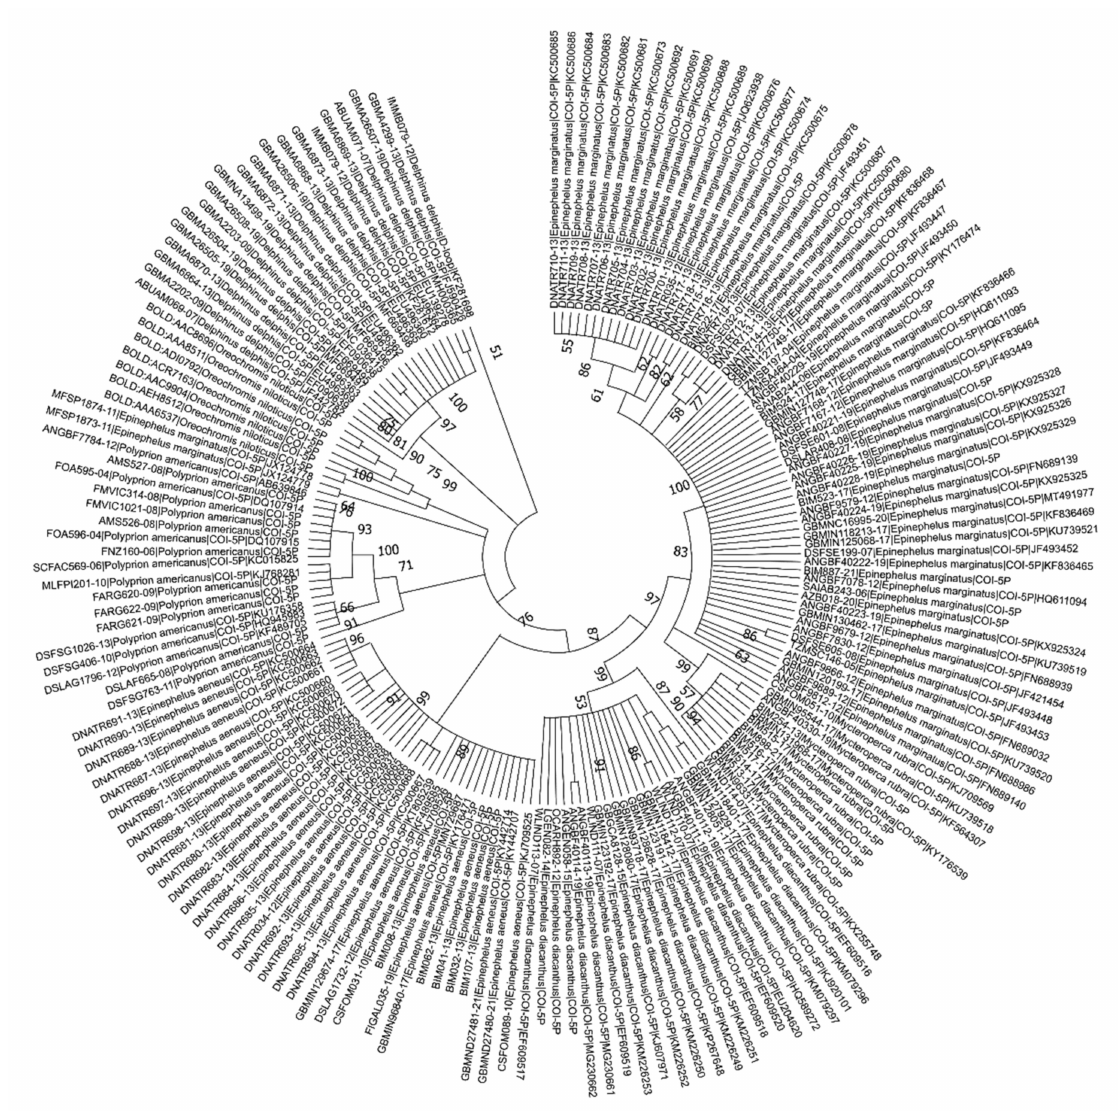
Figure 3. Evolutionary relationships of barcode sequences. Source: our compilation from BOLD